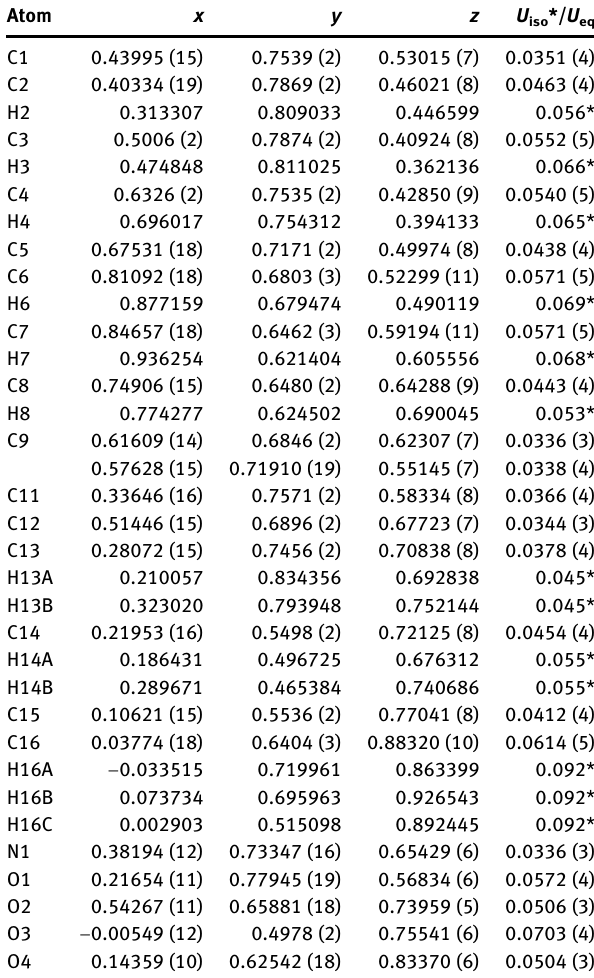
Table  : Fractional atomic coordinates and isotropic or equivalent isotropic displacement parameters (Å 